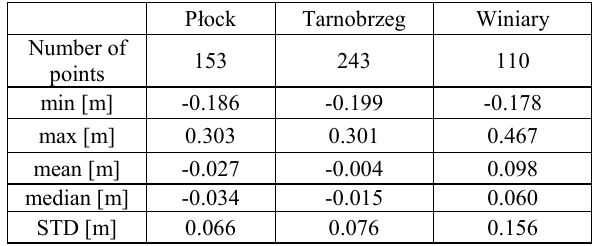
Table 8. Assessment of DTM from ULS data based on the GPS RTK points in the levee